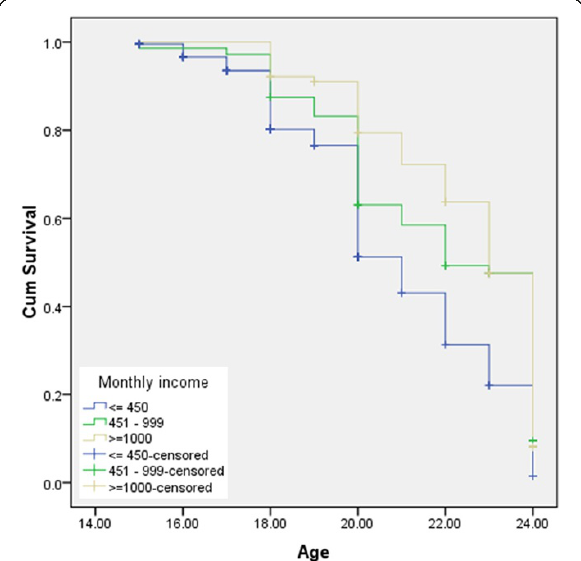
Figure 3 Kaplan-Meier indicating age at sexual initiation among youths with respect to monthly income in Gamo-Gofa, South West Ethiopia (Log Rank chi-square = 28.07, p-value = 0.001).